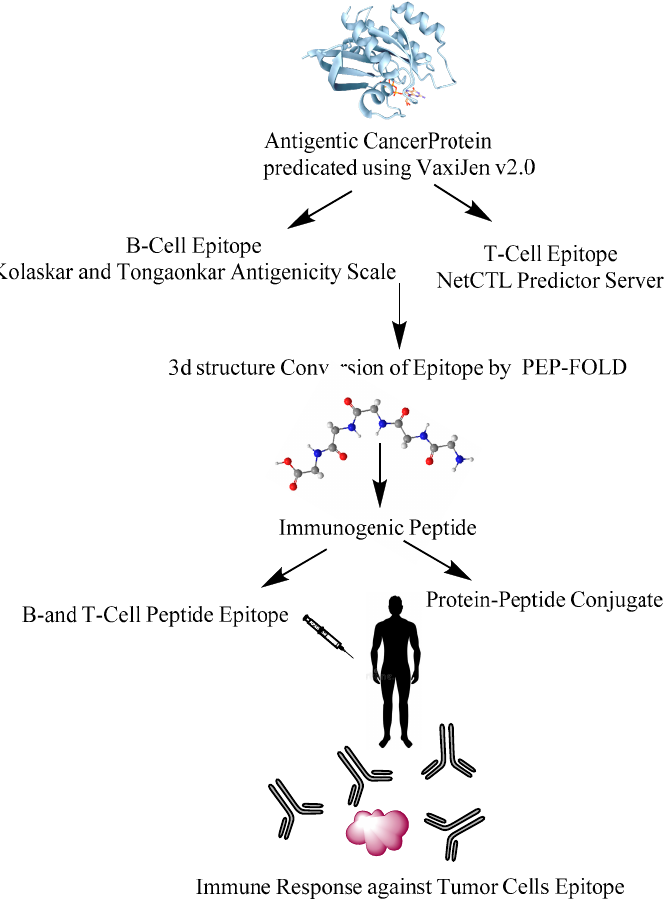
Figure 4. A simplified schematic diagram to design peptide vaccines against tumor